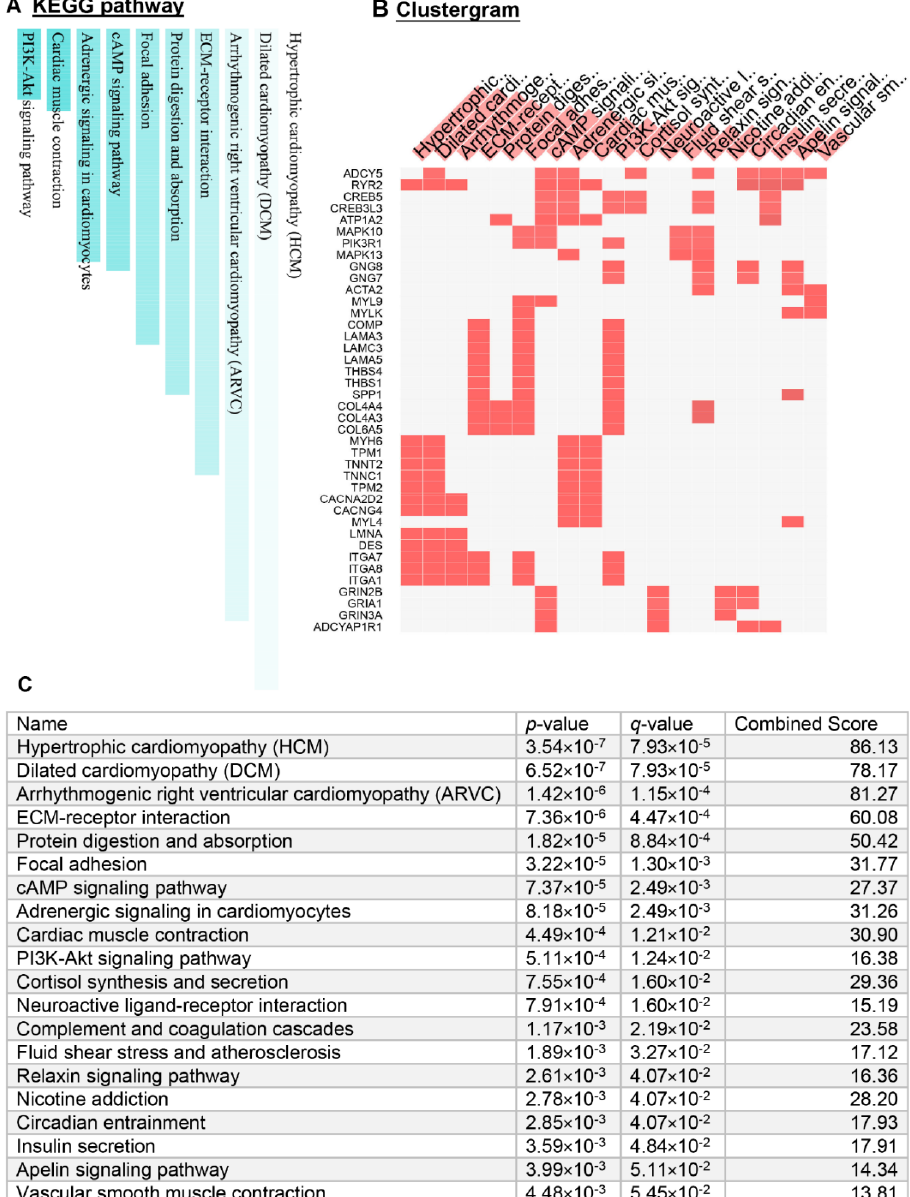
Figure 3. KEGG pathways enriched among DE genes in ovaries between TGFBR1-CA and control mice at the age of 1 month. ( A ) The top 10 differentially regulated signaling pathways. ( B ) Clus- tergram depicting DE genes associated with the top 20 differentially regulated signaling pathways. Note that only 40 out of 715 DE genes are shown. ( C ) Statistical parameters of the top 20 significantly regulated pathways. A full list of pathways is shown in Supplementary Table